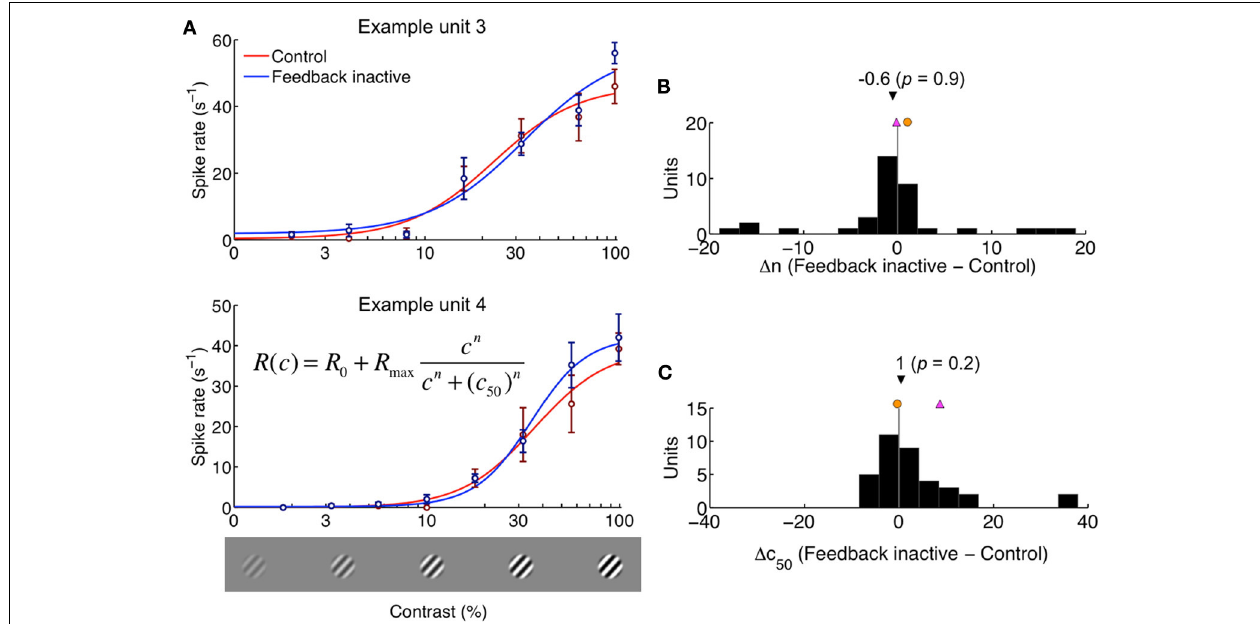
(B) Difference in parameter n between Feedback inactive and Control conditions. (C) Difference in parameter c 50 between Feedback inactive and Control conditions. Black triangle indicates population median (with two-tailed Mann-Whitney U -test p -value). Magenta and orange symbols indicate shifts for example units shown in (A) . Feedback-inactivation did not lead to a systematic effect in contrast response function